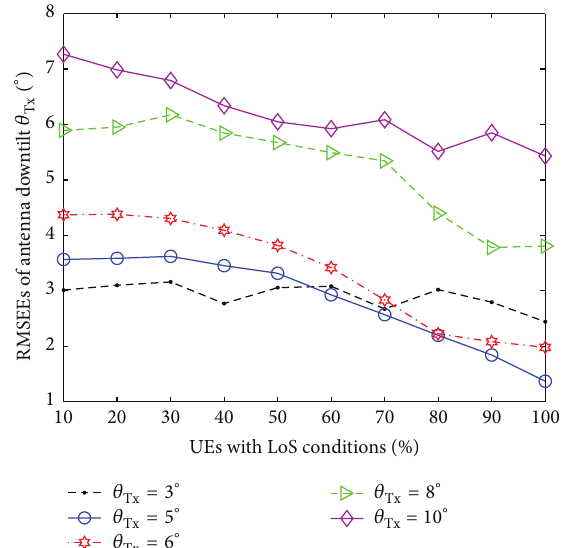
Figure 17: The RMSEEs of antenna downtilt 𝜃 the CFE method versus the percentage of the UEs in the LoS conditions among all